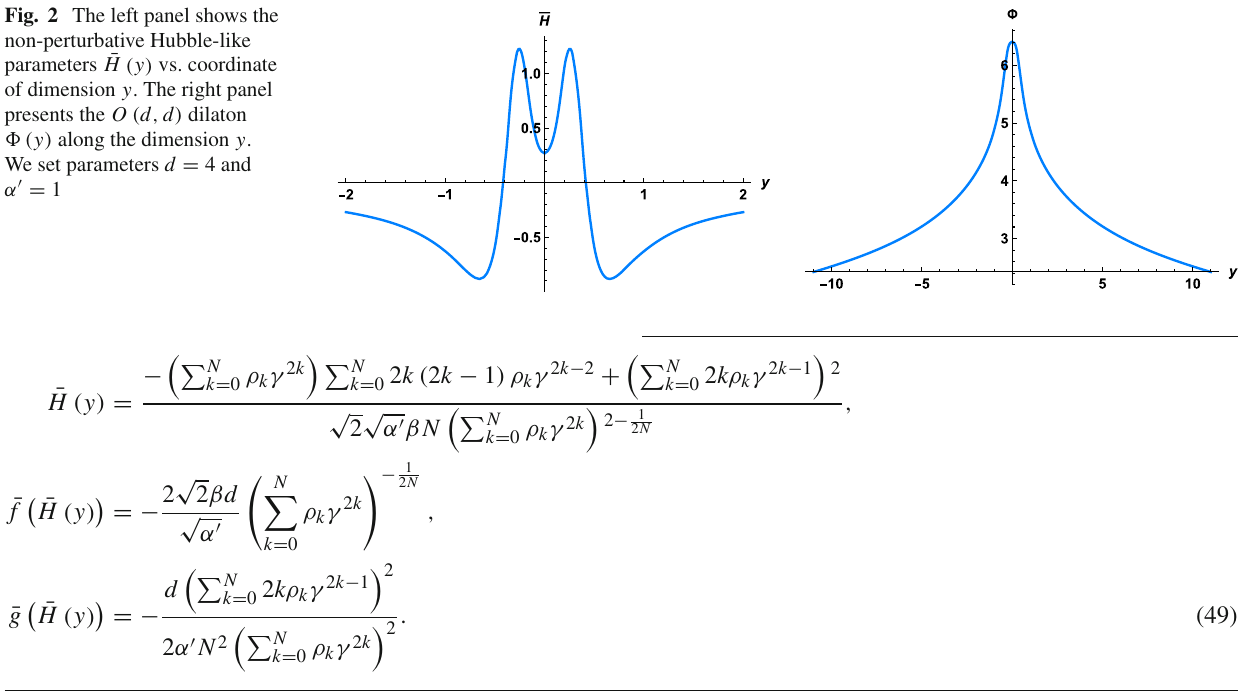
Fig. 2 The left panel shows the non-perturbative Hubble-like parameters ¯ H ( y ) vs. coordinate of dimension y . The right panel presents the O ( d , d ) dilaton (cid:7)( y ) along the dimension y